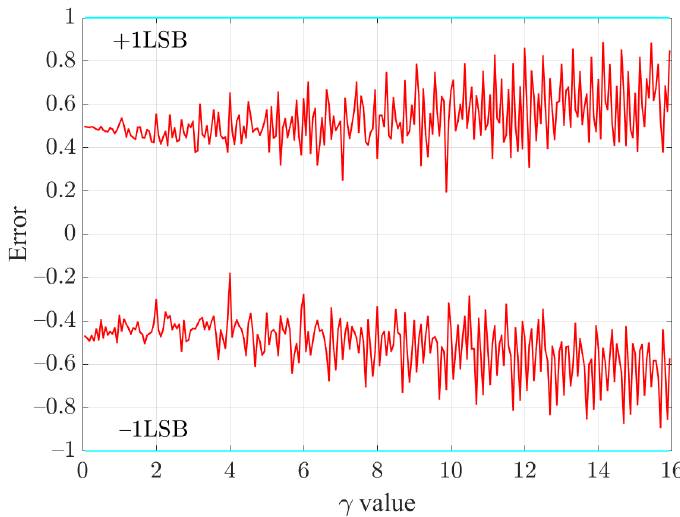
Figure 6. Error at the output for different γ